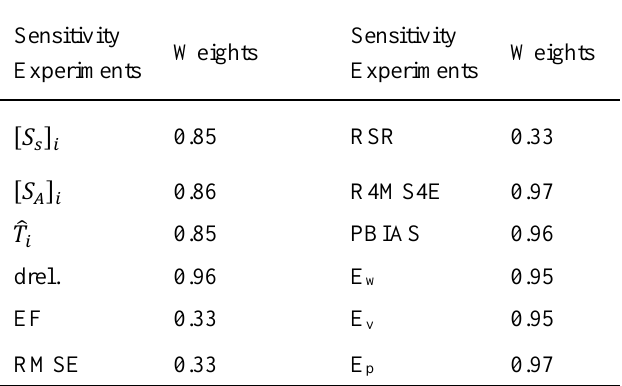
Model performance indices used in the present study Description